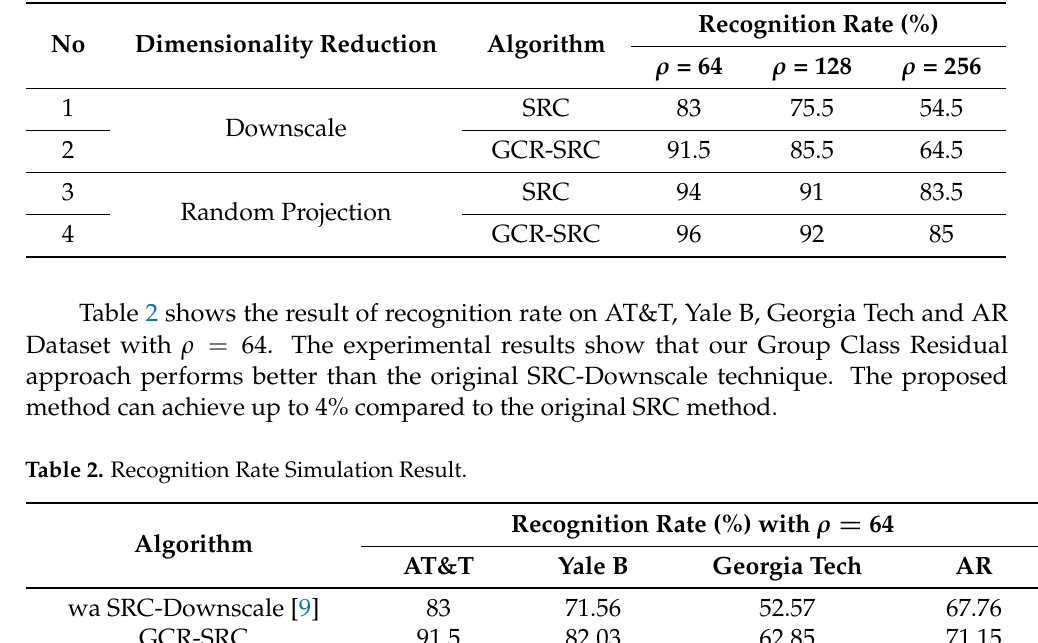
Table 1. Dimensionality Reduction vs. Recognition Rate on AT&T Dataset.